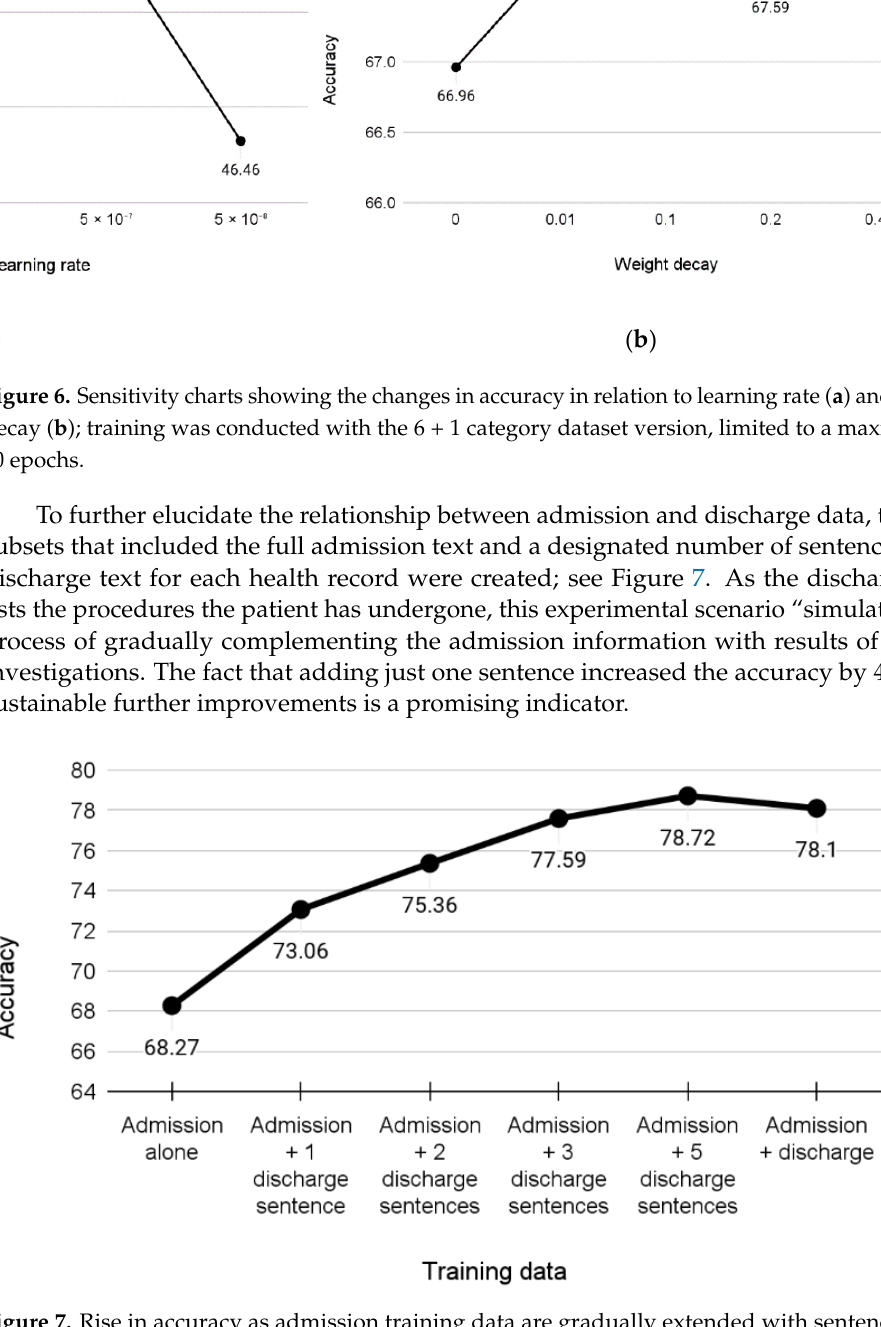
Figure 7. Rise in accuracy as admission training data are gradually extended with sentences from discharge text.